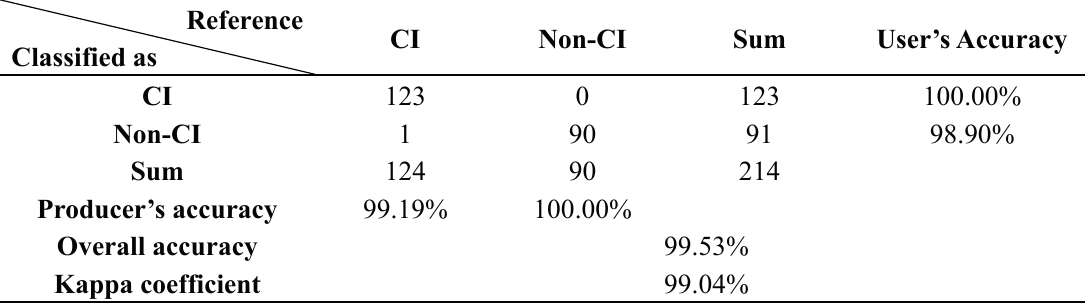
Table 5. Accuracy assessment results for the RF model using the test dataset.